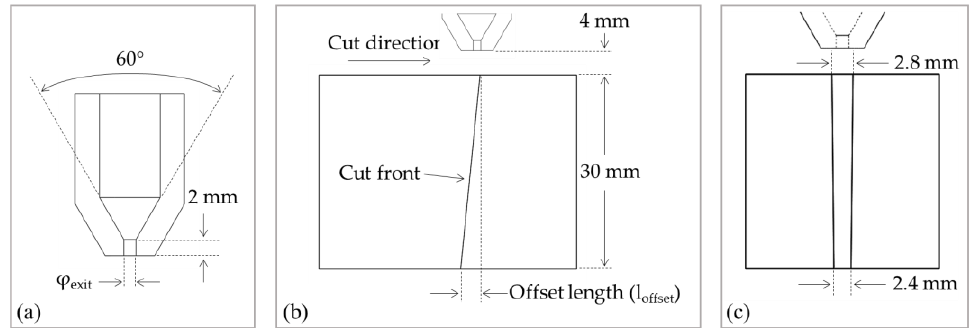
Figure 1. Detailed geometry of nozzle and kerf. ( a ) Nozzle. ( b ) Section view of kerf (perpendicular to the cut direction). ( c ) Side view of the kerf (along the cut